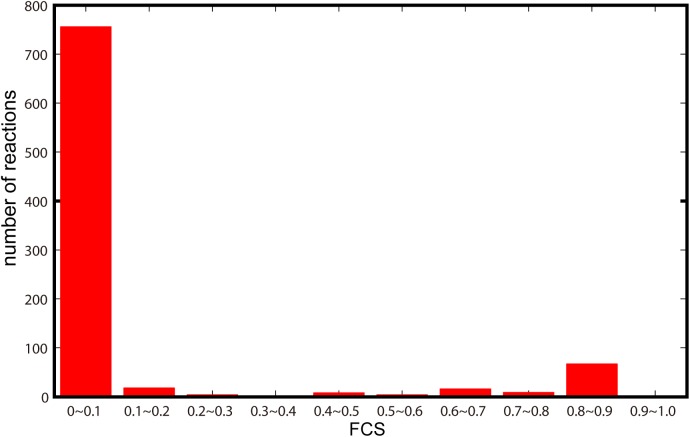
The number of genes under different constraint strengths.The smaller the FCS value, the greater the constraint strength.